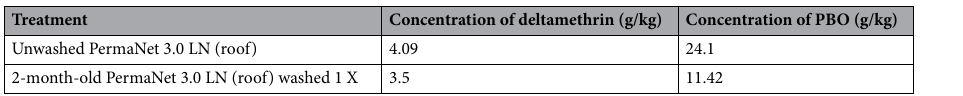
Table 2. Content of deltamethrin and piperonyl butoxide (PBO) in the roof panel of PermaNet 3.0 LN used in release-recapture experiments.